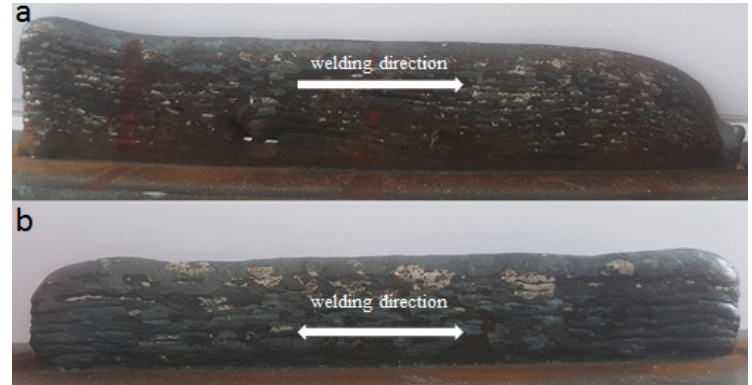
Figure 9. Comparison of geometry depending on the welding orientation, ( a ) discontinuous and ( b ) continuous, with v wire = 2.5 m/min and v welding = 40 cm/min for G4Si1. •